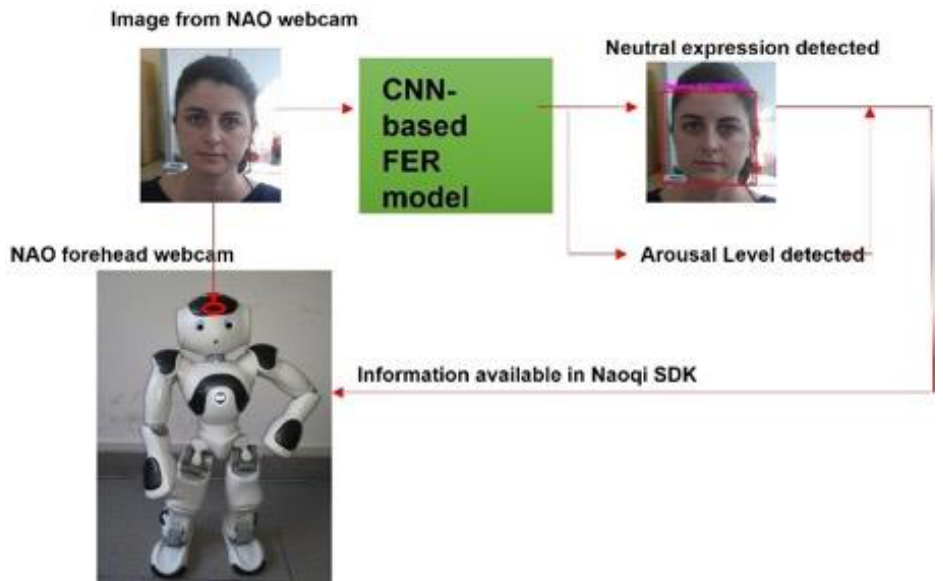
Figure 7. Information-processing workflow. The images were retrieved from NAO’s forehead webcam and analyzed through the CNN-based FER model. The model outcome, integrated into Naoqi SDK, was available for the robot to use.